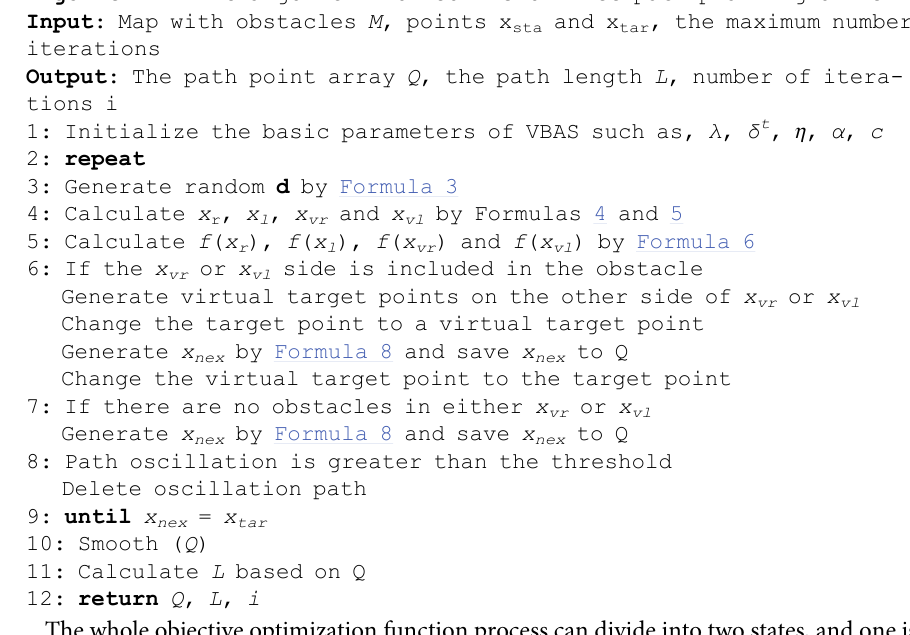
Algorithm 1 VBAS algorithm for collision-free path planning of